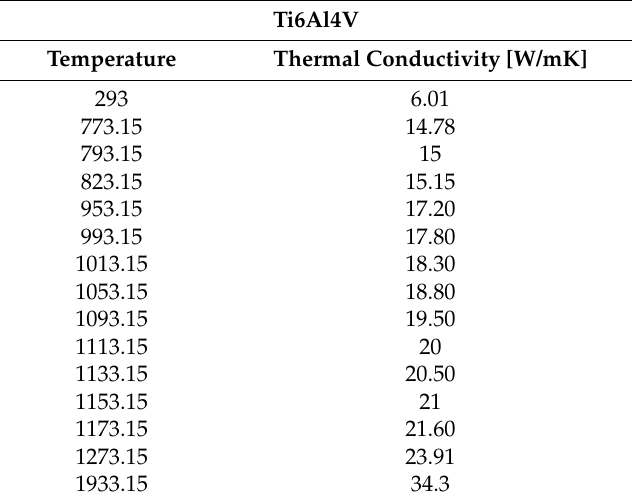
Table 4. Temperature dependent thermal conductivity of